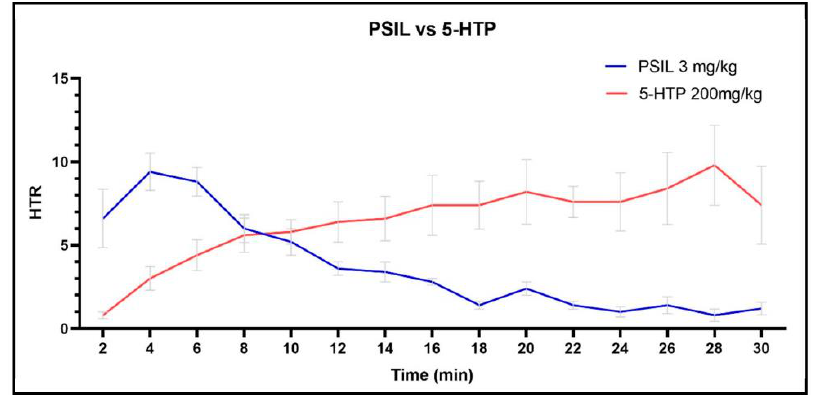
Figure 5. PSIL (3 mg/kg) and 5-HTP (200 mg/kg) HTR profile comparison based on maximal peak HTR. Error bars represent SEM.